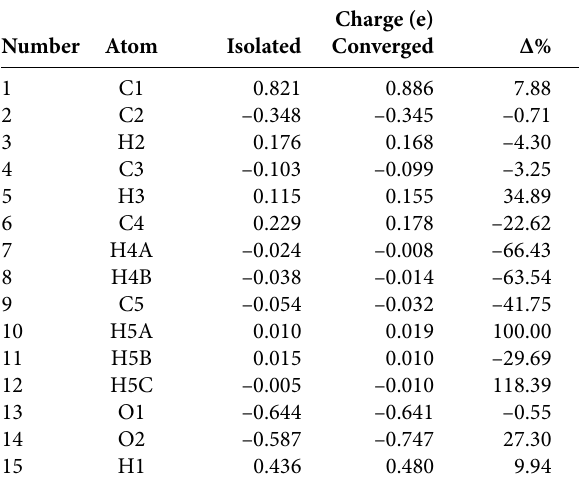
Table 3: MP2/6-311++G(d,p) results for the CHELPG atomic charges of isolated and embedded CAD.